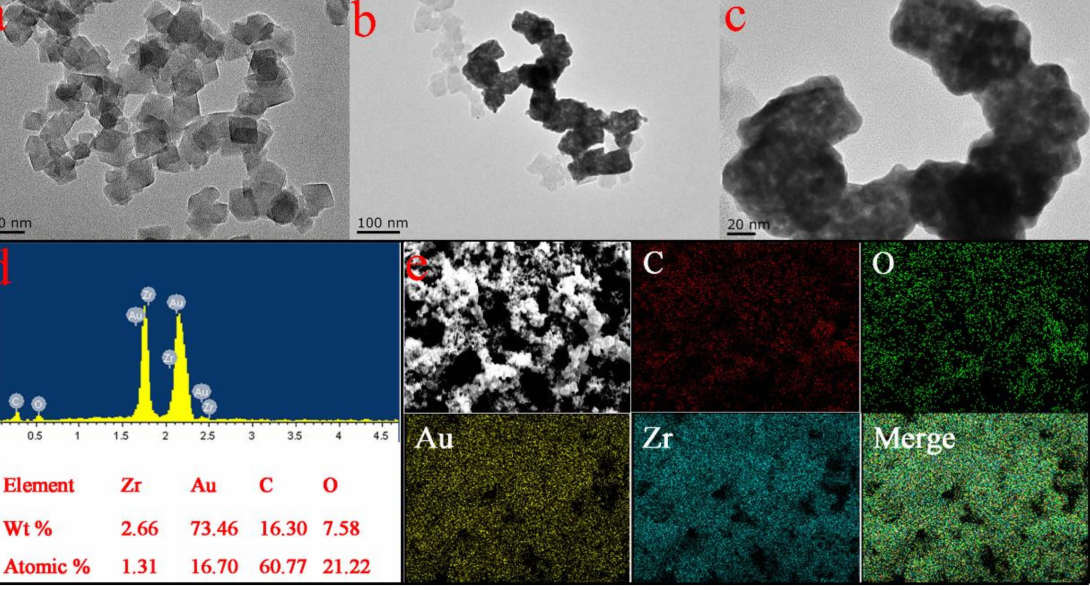
Figure 1. ( a ) TEM images of UiO-66-NH 2 . ( b , c ) TEM image, ( d ) EDS spectra and ( e ) EDS mapping image of